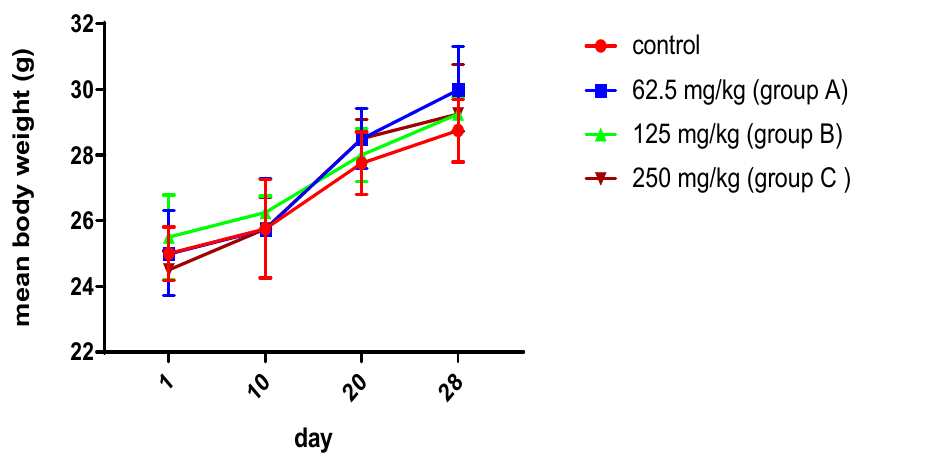
Figure 1 : Effect of oral administration of aqueous extract of B. dioica roots on the bodyweight of treated mice, results represent the means ± SD (standard